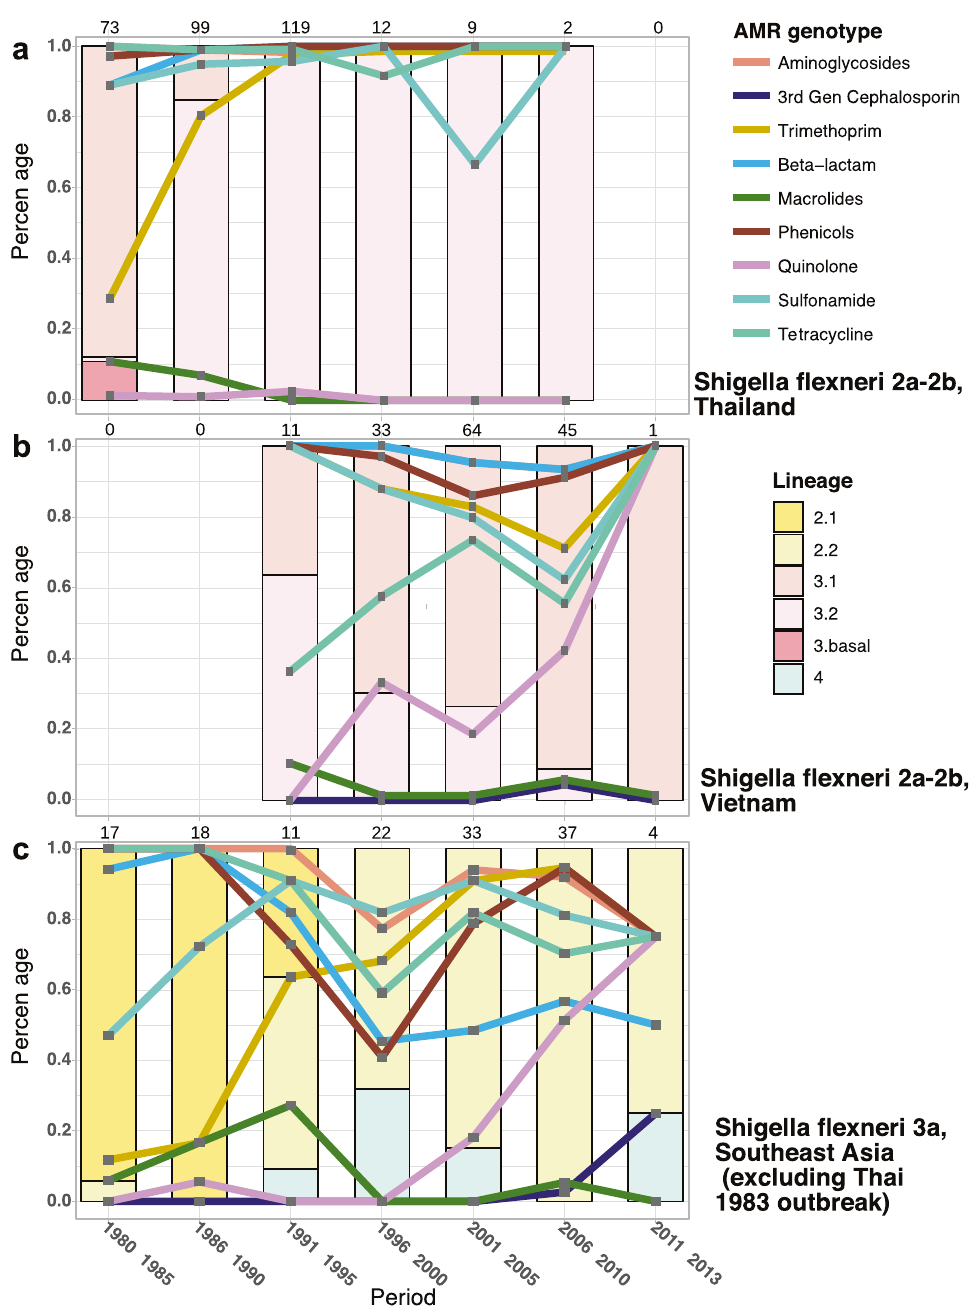
Fig. 4 Clonal replacement of Shigella fl exneri in Southeast Asia. The fi gures display the isolation frequency of major S. fl exneri lineages from 1980 to 2013, speci fi cally for ( a ) serotypes 2 (2a, 2b) from all regions of Thailand, ( b ) serotypes 2 (2a, 2b) from all regions of Vietnam, and ( c ) serotype 3a from all countries across Southeast Asia (Thailand, Vietnam, Cambodia, Laos), excluding 11 Lin-2.2 isolates of a presumptive outbreak in Thailand in 1983 (see Method). The bar charts display the proportional sampling of these populations compared with the total S. fl exneri of the respective serotype isolated during a period (total number of isolates indicated on top of each bar). The percentage of S. fl exneri isolates resistant to a given antimicrobial, determined by identi fi cation of AMR genetic factors, is plotted by line graph. The y-axis (percentage) is used to measure both the isolation proportion of S. fl exneri populations and proportion with resistance to speci fi ed